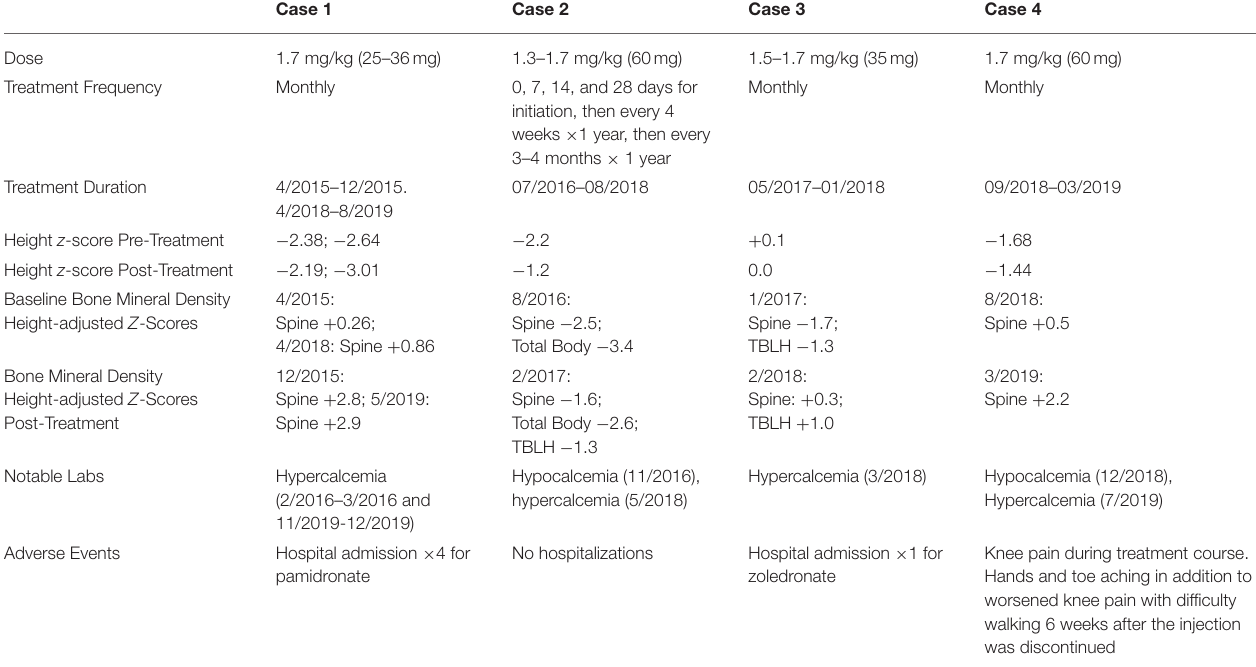
TABLE 2 | Treatment